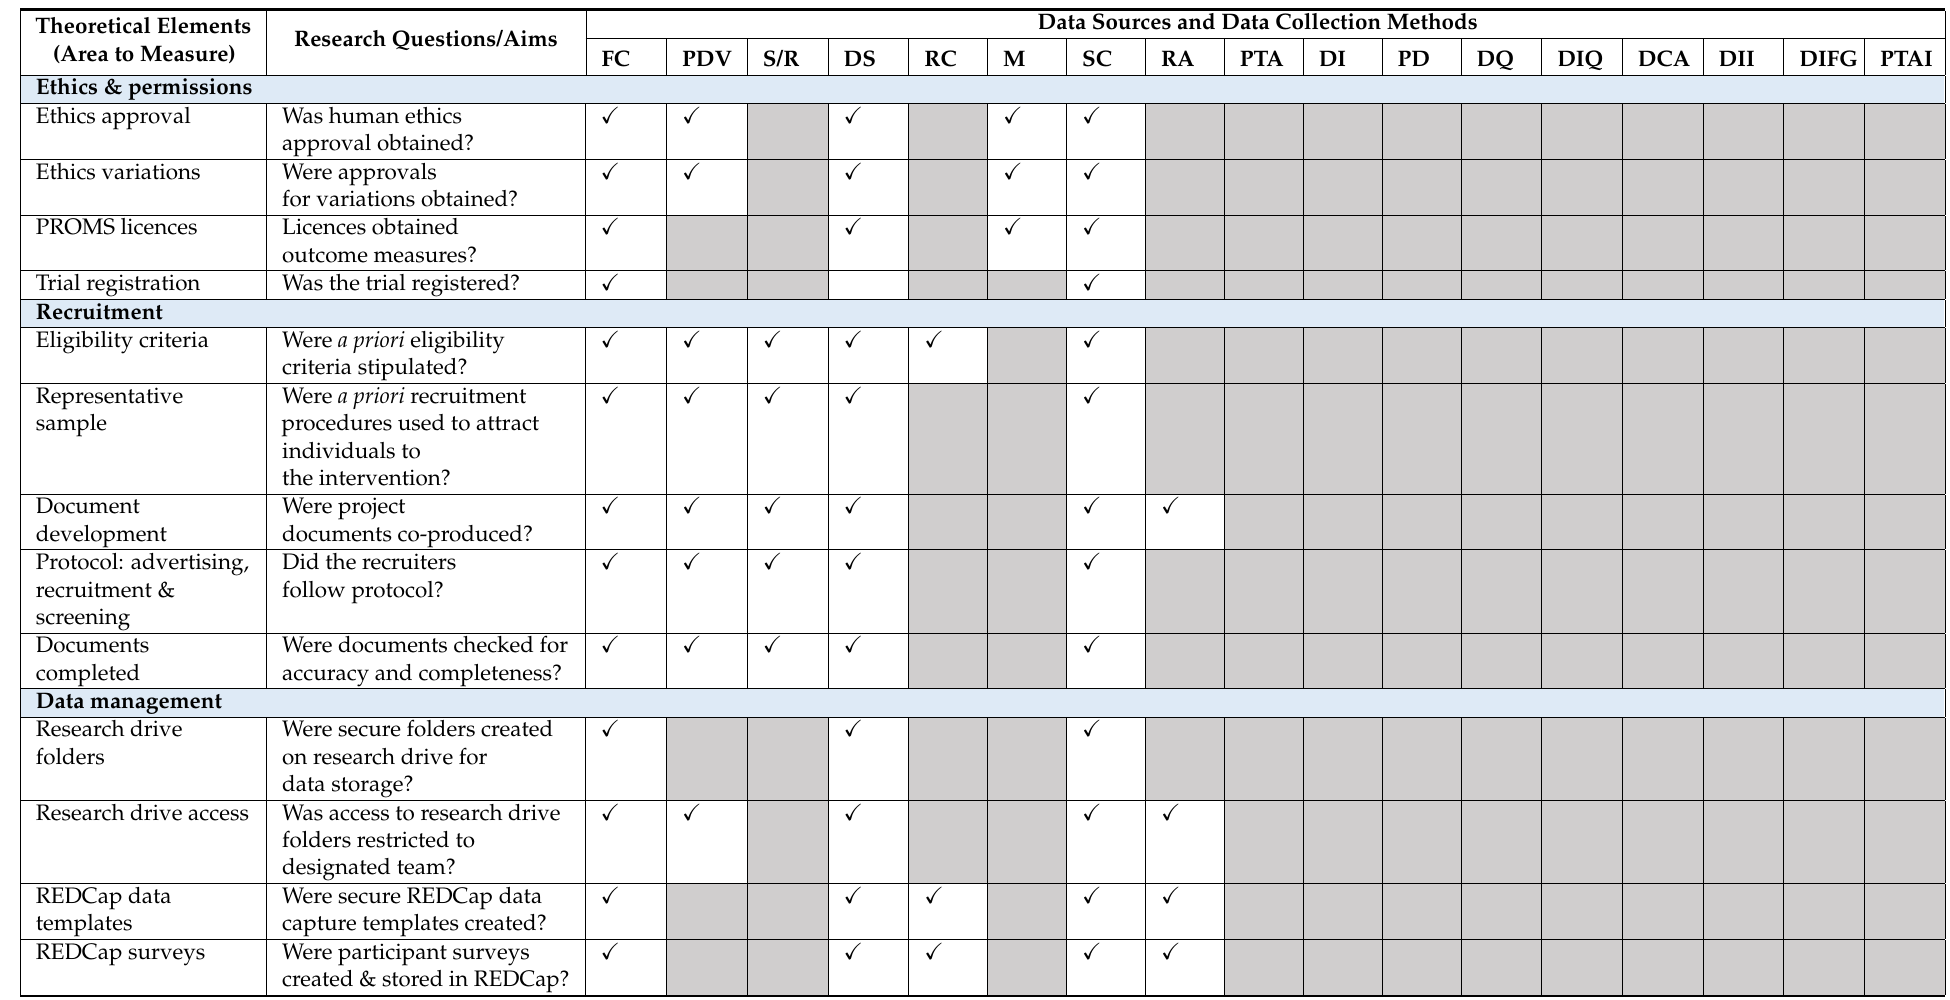
Table 3. Fidelity checking and process